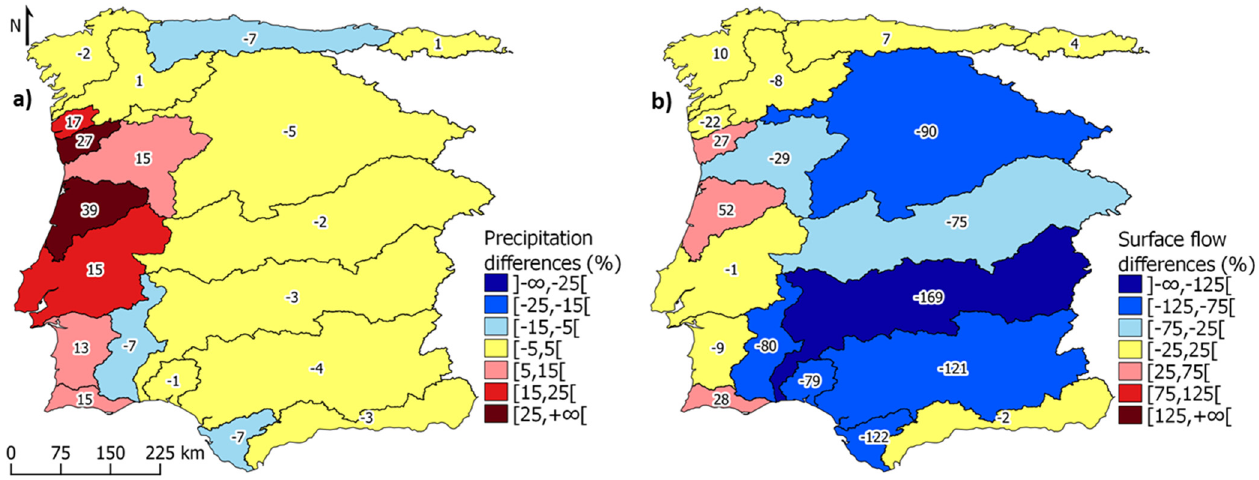
Figure 5. Percentage of difference between model and plan’s precipitation ( a ) and natural surface flow ( b ) values.